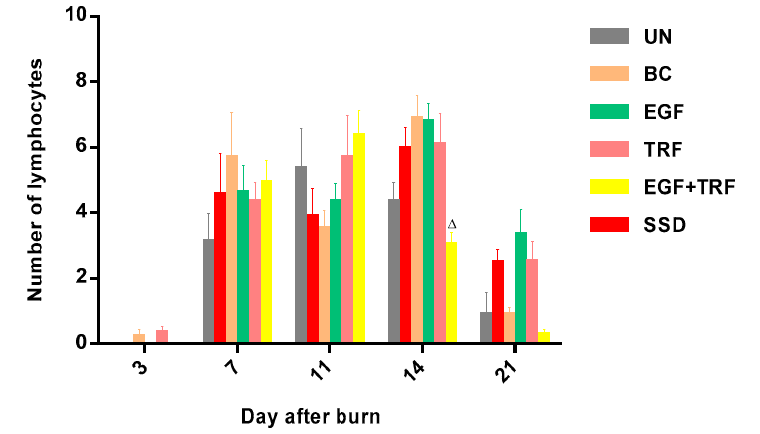
Figure 5. The number of lymphocytes in all the groups over time post-burn. Note: Values calculated over a 21-day trial and expressed as mean ± S.E.M. for six rats. ∆ p < 0.05 compared with those of the SSD group on the respective day.